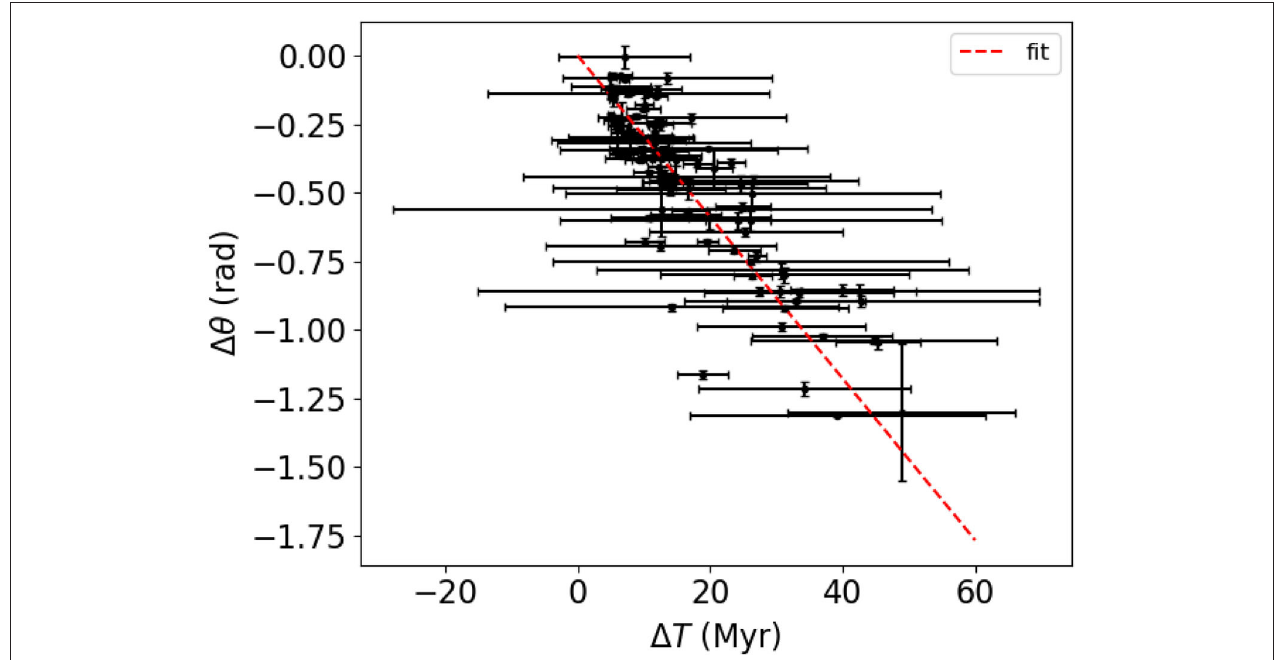
FIGURE 7 | The angle between the birthplaces of the clusters, and the present day position of the corresponding spiral arm (zero age) at the same Galactic radius. The birthplaces were obtained using for integration the rotation curve without dip. The points represent the total sample. The slope of the linear fit to 1θ (cid:127) p = 28.5 ± 0.8 kms − 1 kpc − 1 , that we adopt as our final